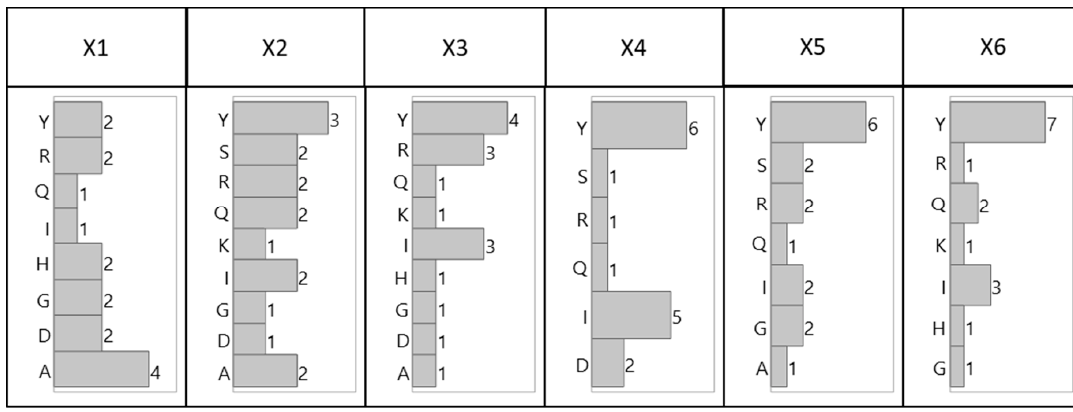
Figure 3. Distribution of amino acid residues for lead hexameric HCP-binding peptide candidates identified by ClonePix 2 sorted solid-phase fluorescent screening by combinatorial position.